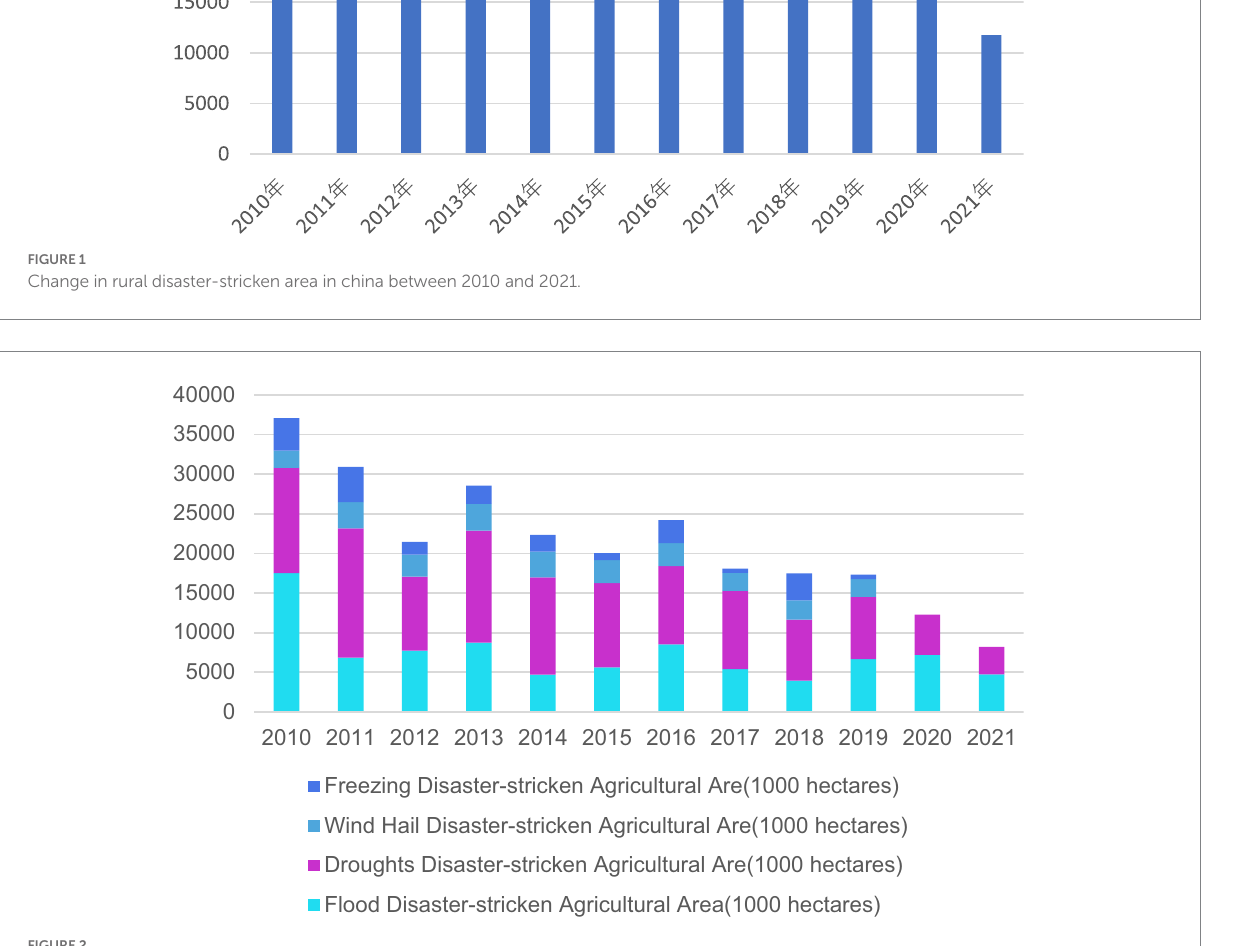
FIGURE 2 Composition of disaster-stricken agricultural area in